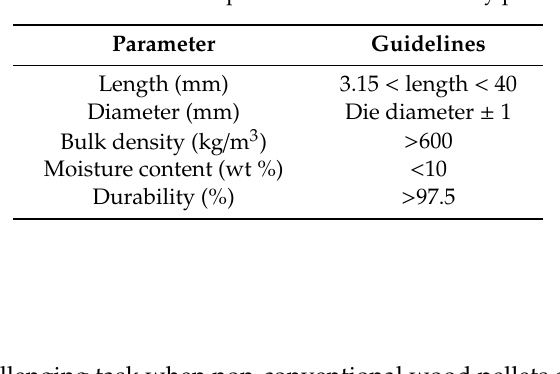
Table 1. Guidelines for specifications of non-woody